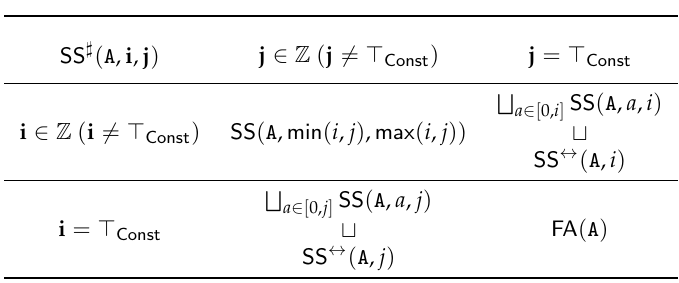
Table 1. Definition of SS (cid:93) .